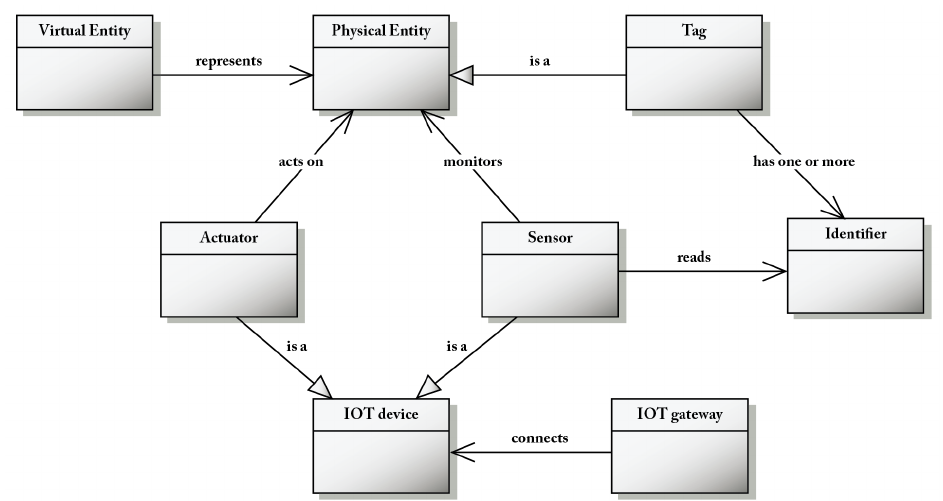
Figure 5. Virtual entity, physical entity, and IoT device concepts of the CM.